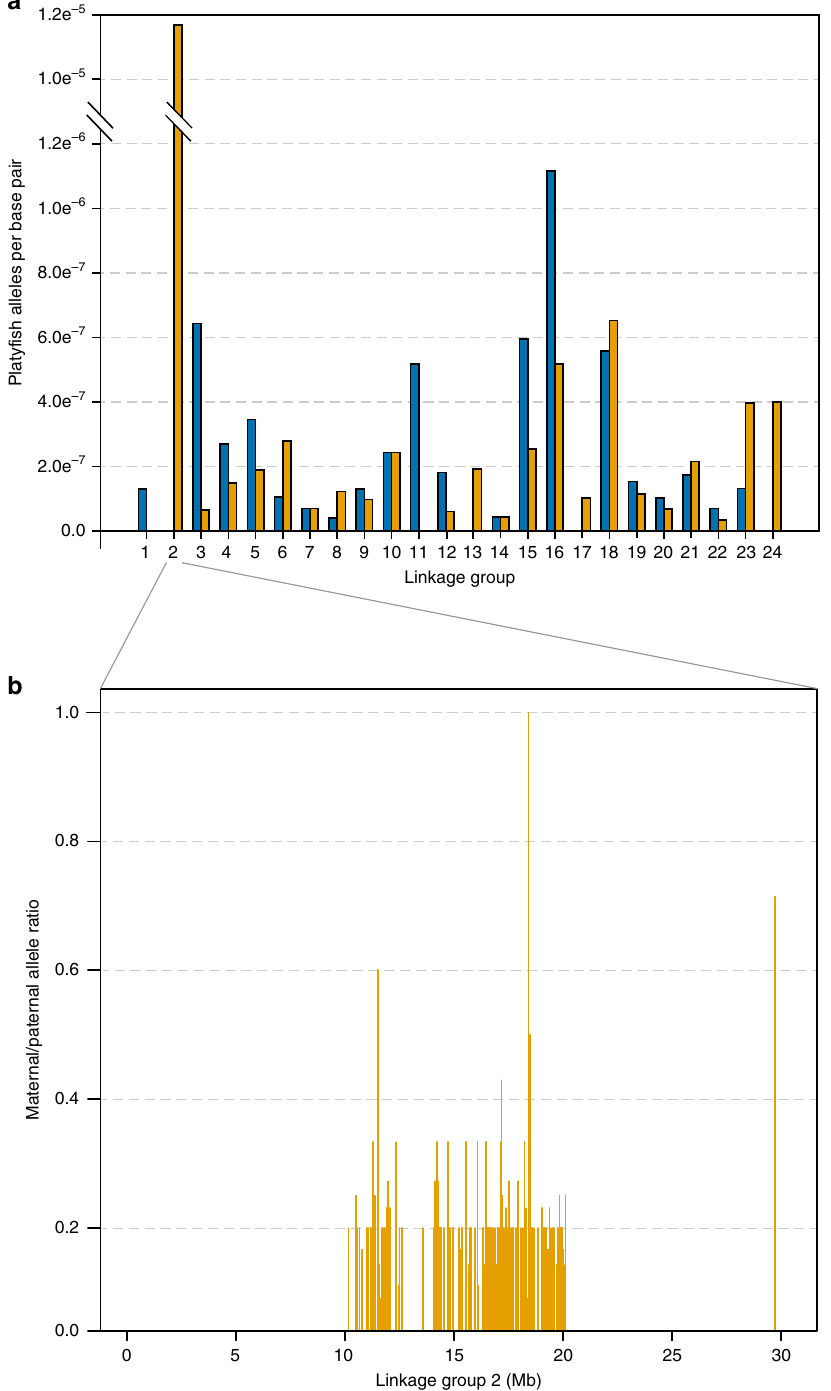
Fig. 4 Segregation patterns of parental alleles. a Frequency of loci carrying platy fi sh alleles in the BC 100 _wt (blue bars) and BC 100 _pigm (orange bars) in each of the 24 linkage groups of the X. maculatus genome; b frequency of maternal alleles across linkage group 2